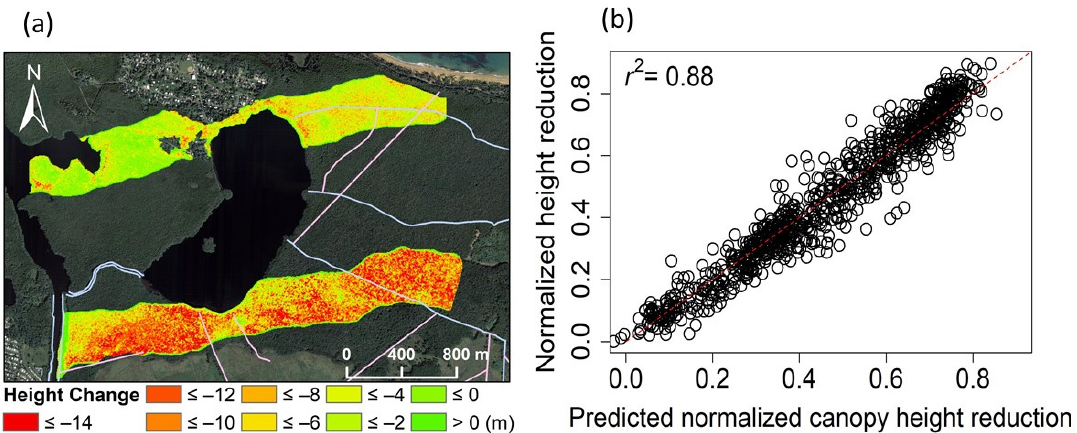
Figure 6. Canopy height change by the hurricanes calculated as disturbed minus intact canopy height ( a ), and model- predicted versus LiDAR-derived normalized canopy height reduction ( b ).